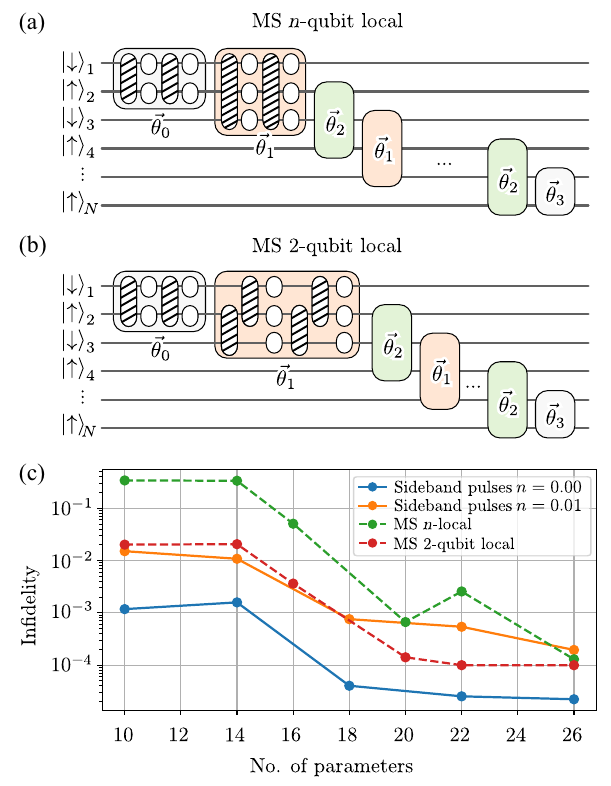
FIG. 7. Efficiency comparison for the variational Ansatz cir- cuits: circuit using the sideband operations considered in the present paper with n ¼ 0 and n ¼ 0 . 01 average number of phonons in the initial thermal state of the c.m. mode and the alternative circuits (a) and (b) using the nonadiabatic MS operations with the fixed values and without experimental imperfections. In (a), MS operations can be applied to n local qubits and, in (b), only to neighbor pairs of qubits. The MS operations (with the optimal fixed angle) are given by pattern- filled ovals. White ovals represent variational σ z i rotations. (c) Optimized infidelity for the eight-qubit SSH model at δ ¼ 0 , t 0 . 5 of the states prepared using the circuit for a − ¼ given number of variational